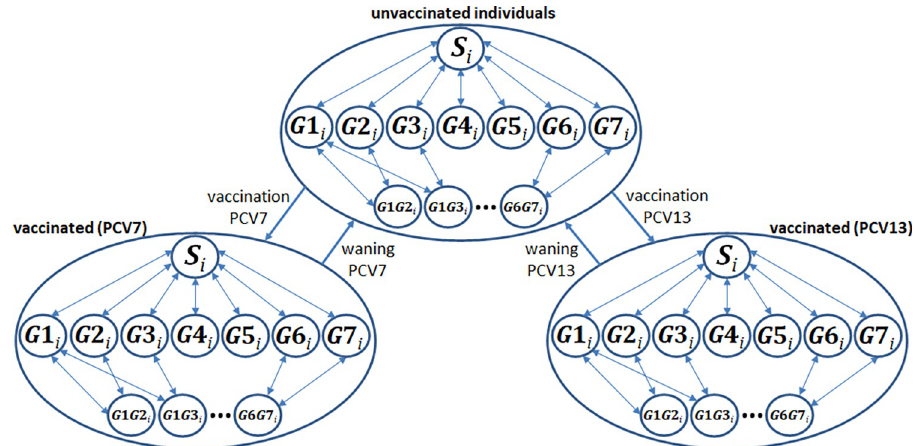
Fig 2. Scheme of the vaccination model. The model is an extension of the epidemiological model depicted in Fig 1. Three different states were distinguished: individuals can be unvaccinated or vaccinated with either PCV7 or PCV13. Transitions between states were described via vaccination and waning rates. For a detailed description see text. S : non- carriers; G 1, ... , G 7: carriers of serotype group 1, ... ,7; G 1 G 2, ... , G 6 G 7: double carriers (2 serotype groups); I = 1, ... ,400: age